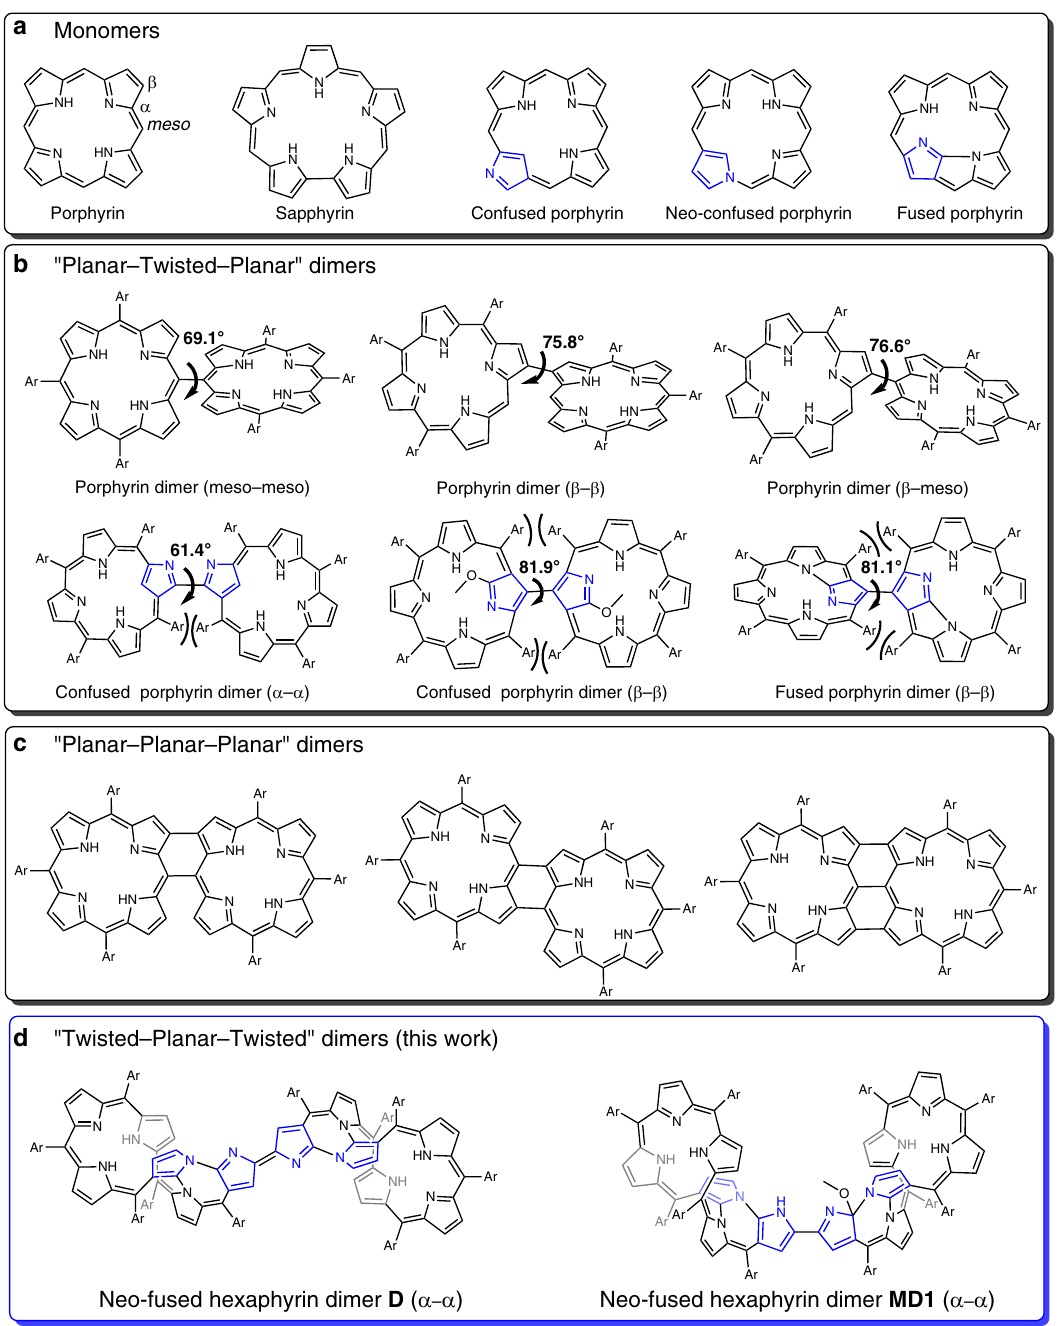
Fig. 1 Chemical structures of porphyrin, porphyrin analogs, and their dimers. a Porphyrin and related monomeric macrocycles; b examples of “ Planar – Twisted – Planar ” dimers: the two planar porphyrin/porphyrinoid units are linked in a highly twisted manner; c examples of “ Planar-Planar-Planar ” dimers: the two planar porphyrin units are linked by means of direct fusion; d “ Twisted – Planar – Twisted ” dimer D reported in this work: Note that the twisted hexaphyrin units are linked through a coplanar bipyrrolic linkage. Ar represents aromatic substituents. The blue-colored pyrrolic units represent confused pyrroles, which are linked with adjacent pyrroles or meso-carbons through C α -C β or N-C β